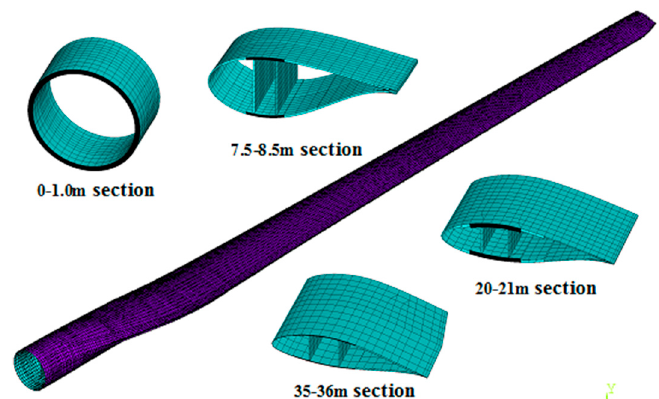
Figure 10. Finite element method (FEM) model of the blade.